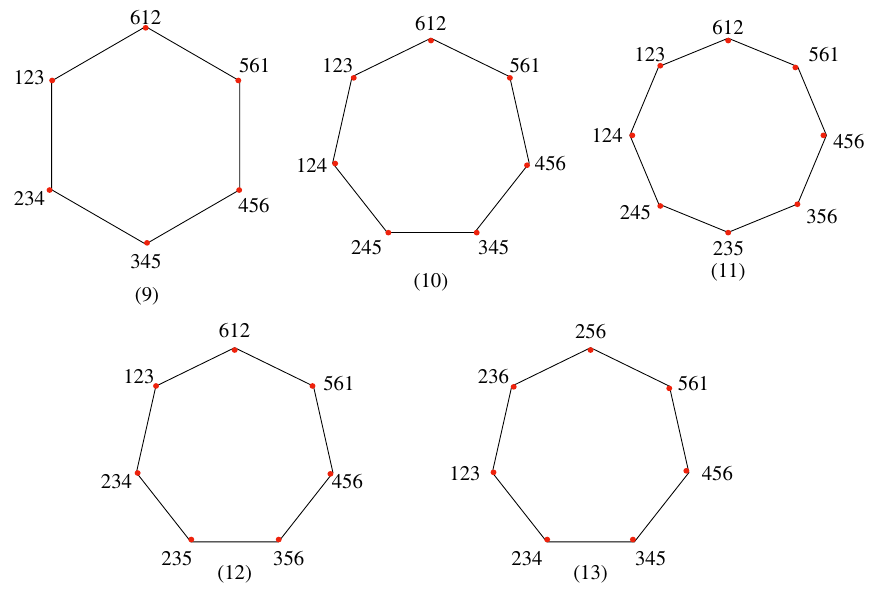
Figure 4 . Polygons for A 245